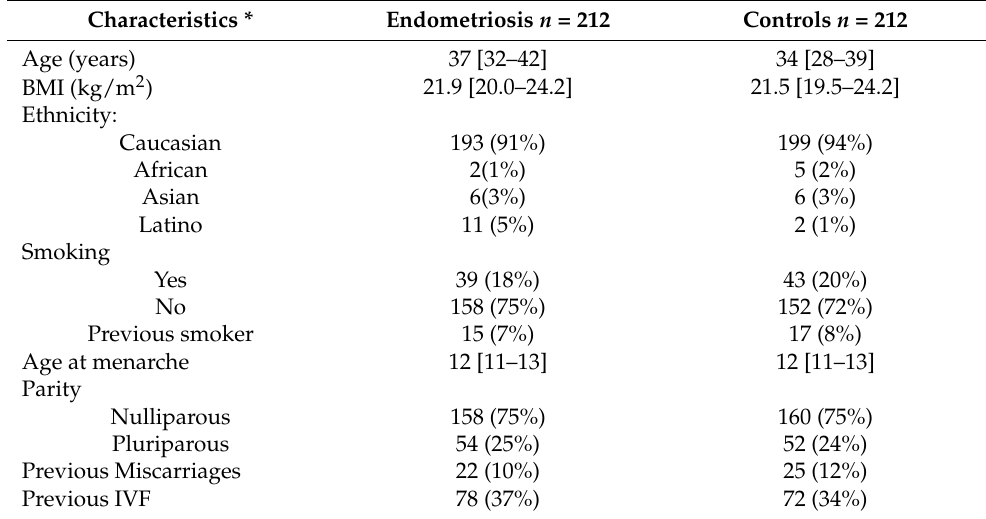
Table 2. Distribution of baseline characteristics of women with endometriosis ( n = 212) and controls ( n =